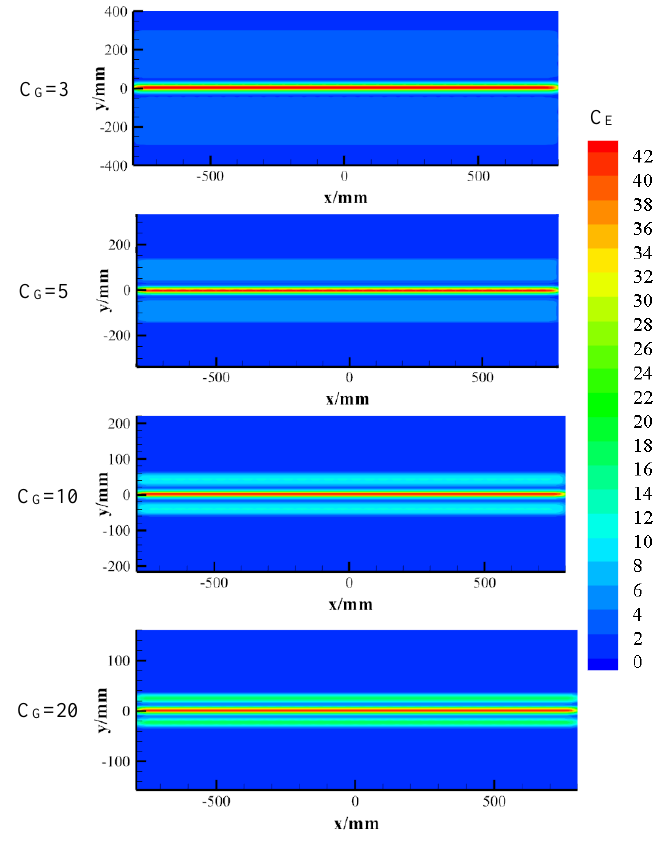
Figure 11. Heat flux distributions at different Geometric Concentration Ratios of PVR.